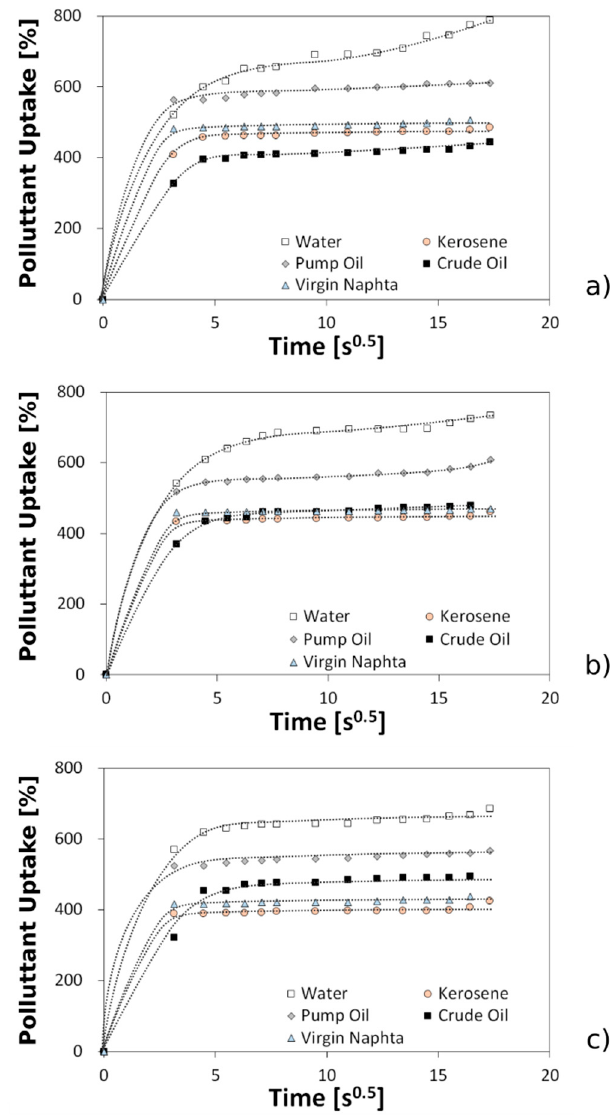
Figure 3. Sorption capacity at increasing time for all pollutants of AF-L ( a ), AF-M ( b ), and AF-S ( c ) samples.